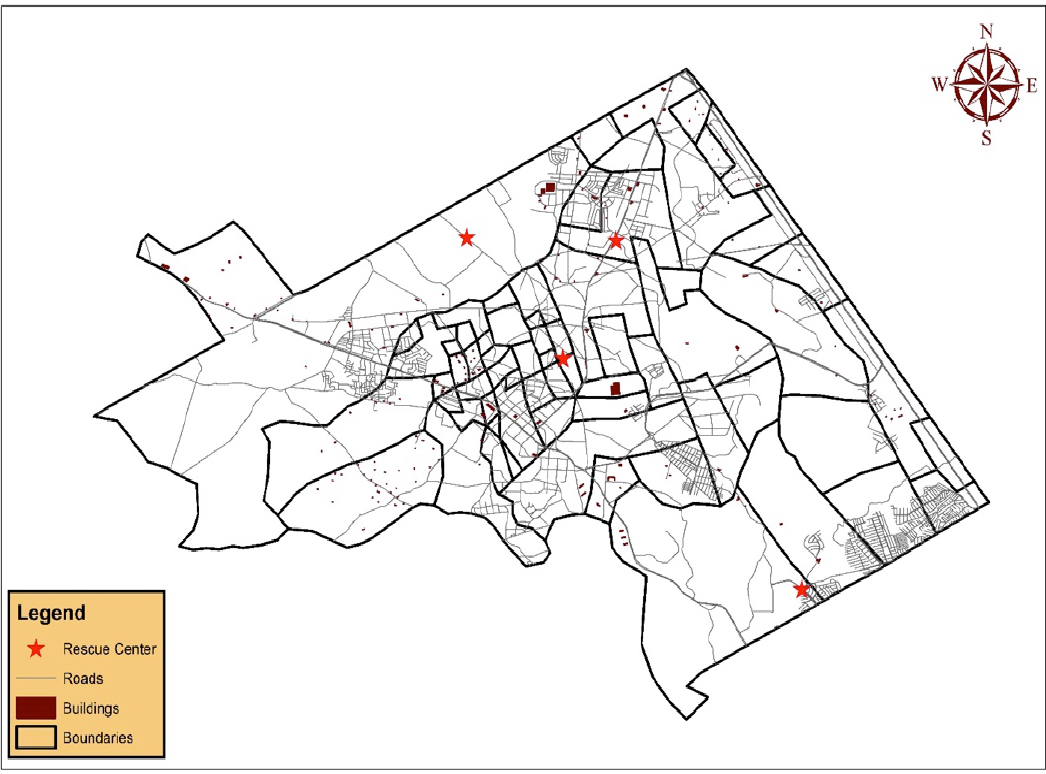
Figure 5. A screenshot of the NetLogo environment for experiment 1 given in Table 3. Table 3. Simulation